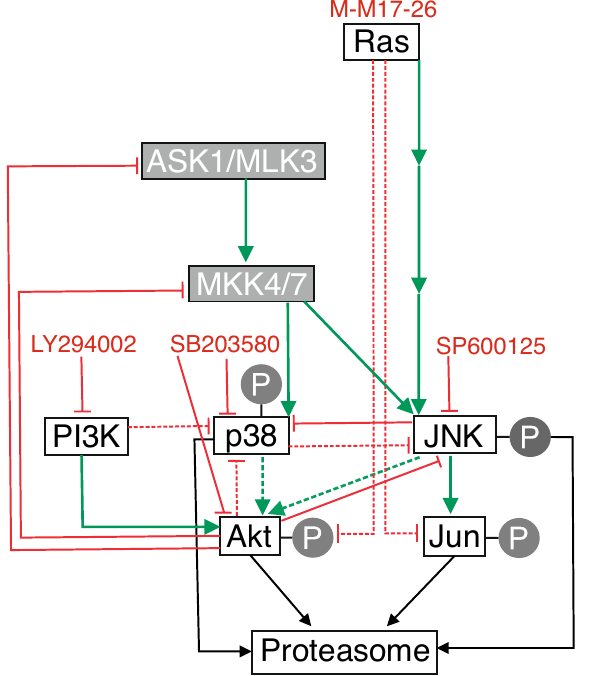
Figure 6. Proposed summary of proteasome inhibitor- and kinase inhibitor-induced signaling in PC12 cells. Activation is indicated by green arrows, inhibition by red lines. Dashed lines represent proposed connections based on our presented results, continuous lines show already confirmed connections. Signaling molecules studied in this work are indicated in white boxes with black captions, other components not studied by us are in grey boxes with white